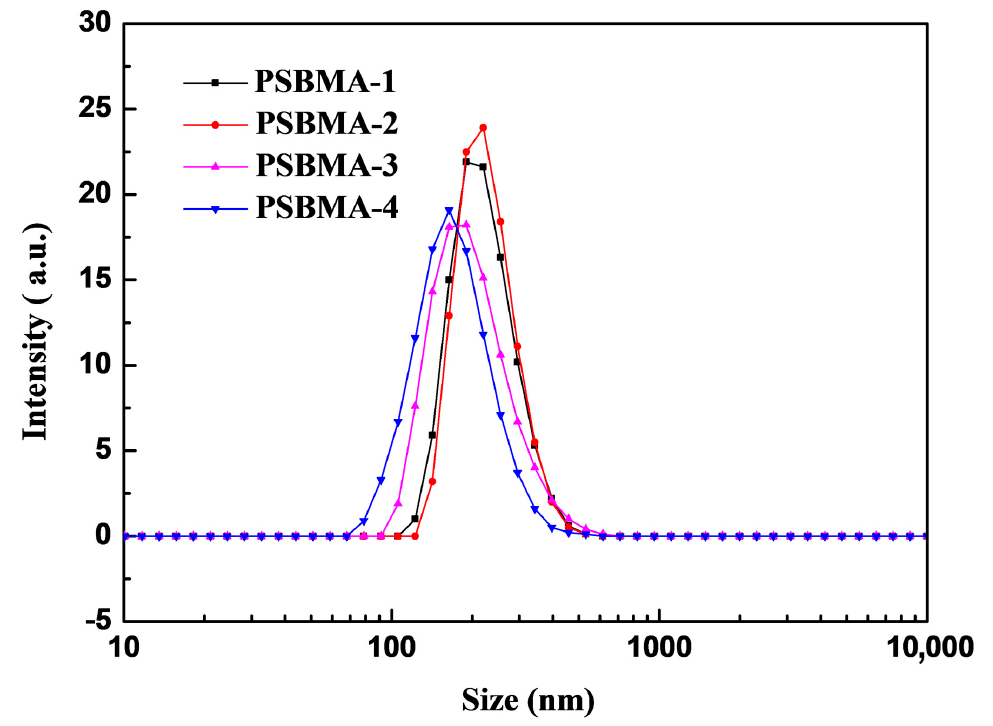
Figure 2. Size distributions for the series of PSBMA nanogels determined by DLS.